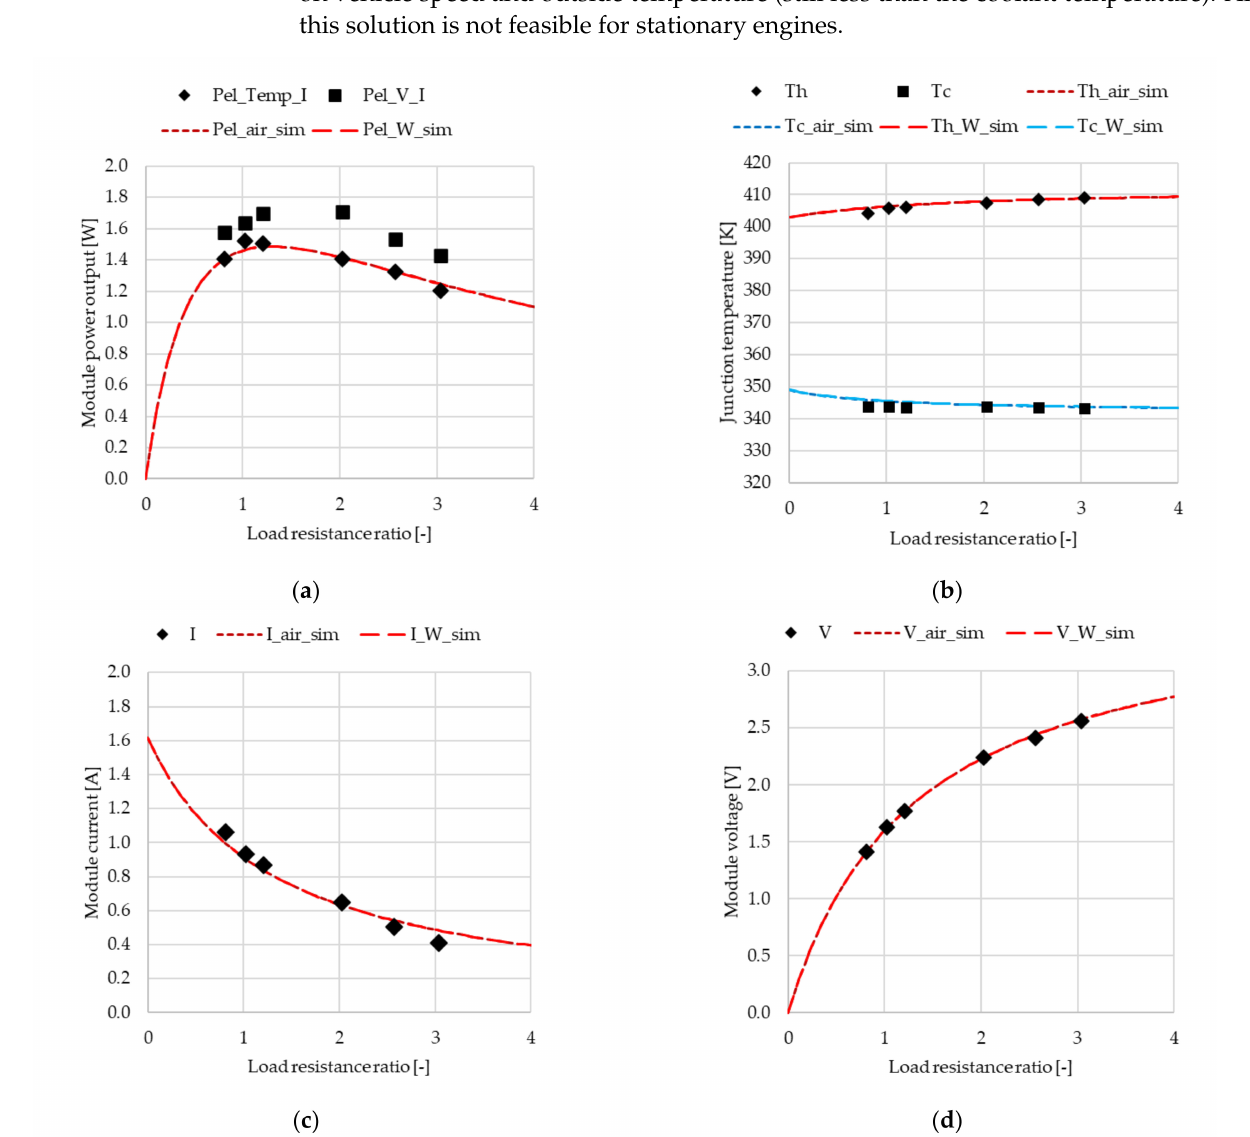
Figure 14. TEG model validation highlighting the difference between the simulated and measured values of ( a ) the electrical power output, ( b ) hot and cold junction temperatures, ( c ) current, and ( d ) voltage for two different types of cold side heat exchangers: Water (W_sim) and air